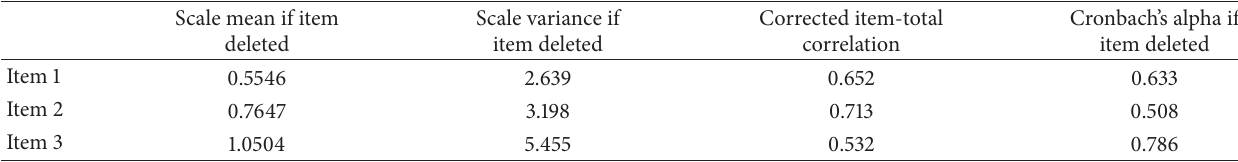
Table 2: Internal consistency statistics.